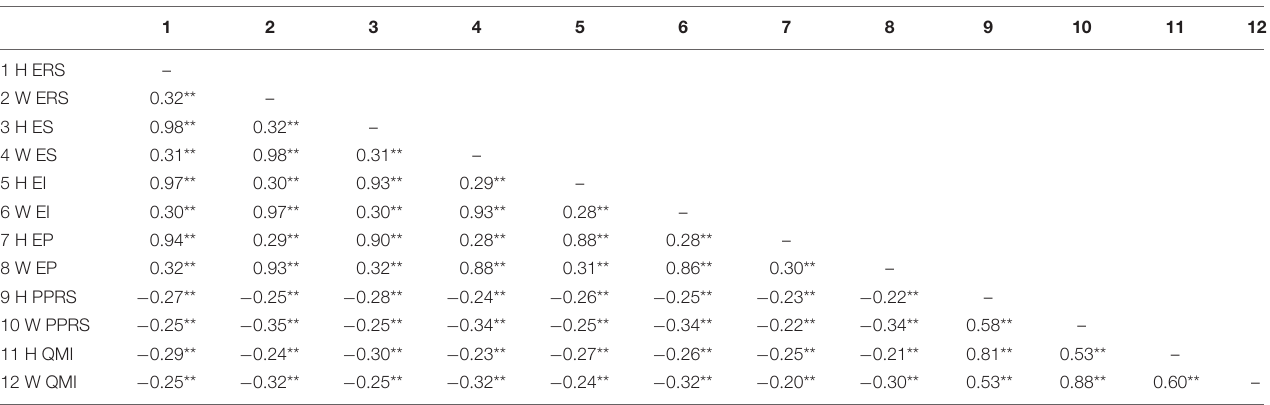
TABLE 2 | Correlations among study variables.